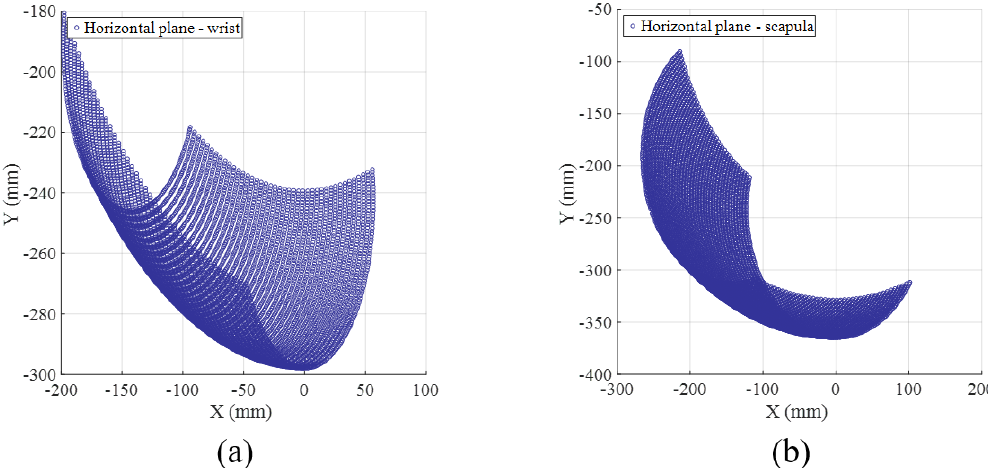
Figure 10. The motion space in the horizontal plane. (a) The motion space of the wrist in the horizontal plane. (b) The motion space of the scapula in the horizontal